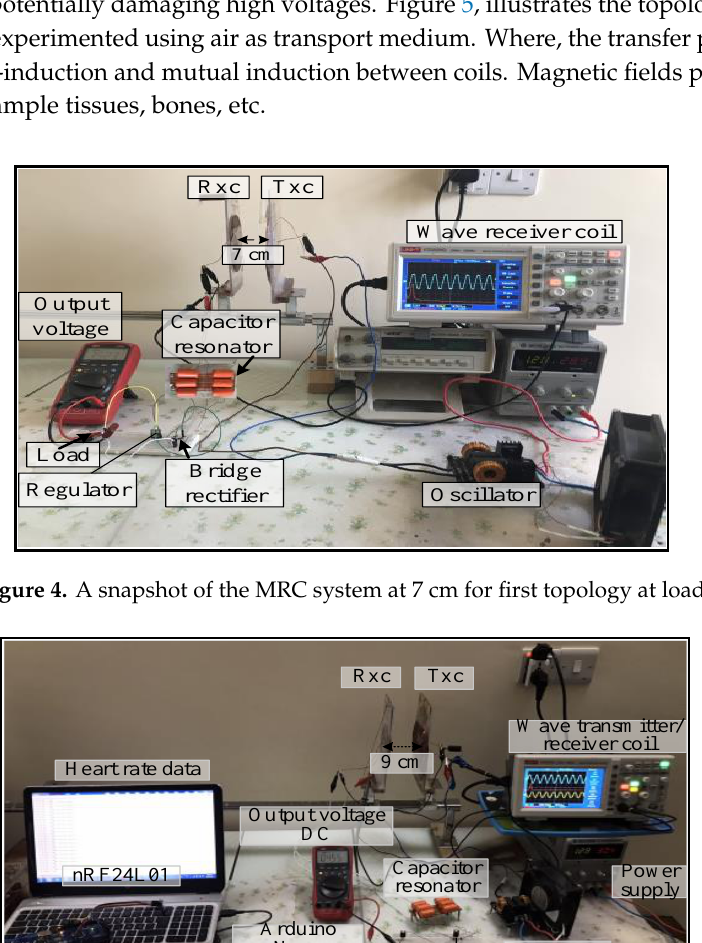
Figure 6. A snapshot of the MRC system at 7 cm for the second topology under load.